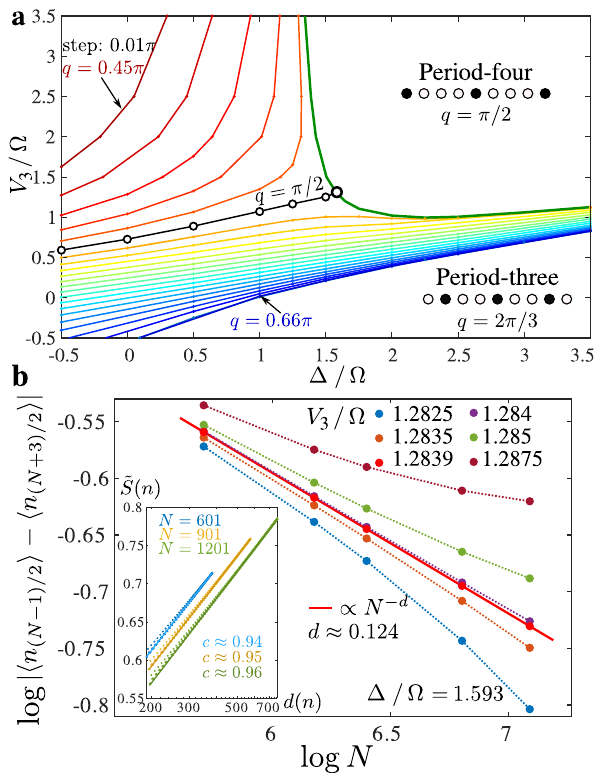
Fig. 3 Identi fi cation of the conformal point. a Phase diagram with equal- q lines in the disordered phase extracted for N = 601 (systematically) and for N = 1201 (in the vicinity of the critical lines). Colors used for equal- q lines are guides to the eye. The location of the Ashkin – Teller point has been determined as the crossing point of the critical (green) line and the q = π /2 line (black, open circles). b Finite-size scaling of the amplitude of the oscillations in on-site boson density in the middle of the fi nite-size chain. The separatrix corresponds to the critical point. Inset: Scaling of the entanglement entropy with the conformal distance d ( n ) after removing the Friedel oscillations, leading to a central charge c ≃ 0.96.